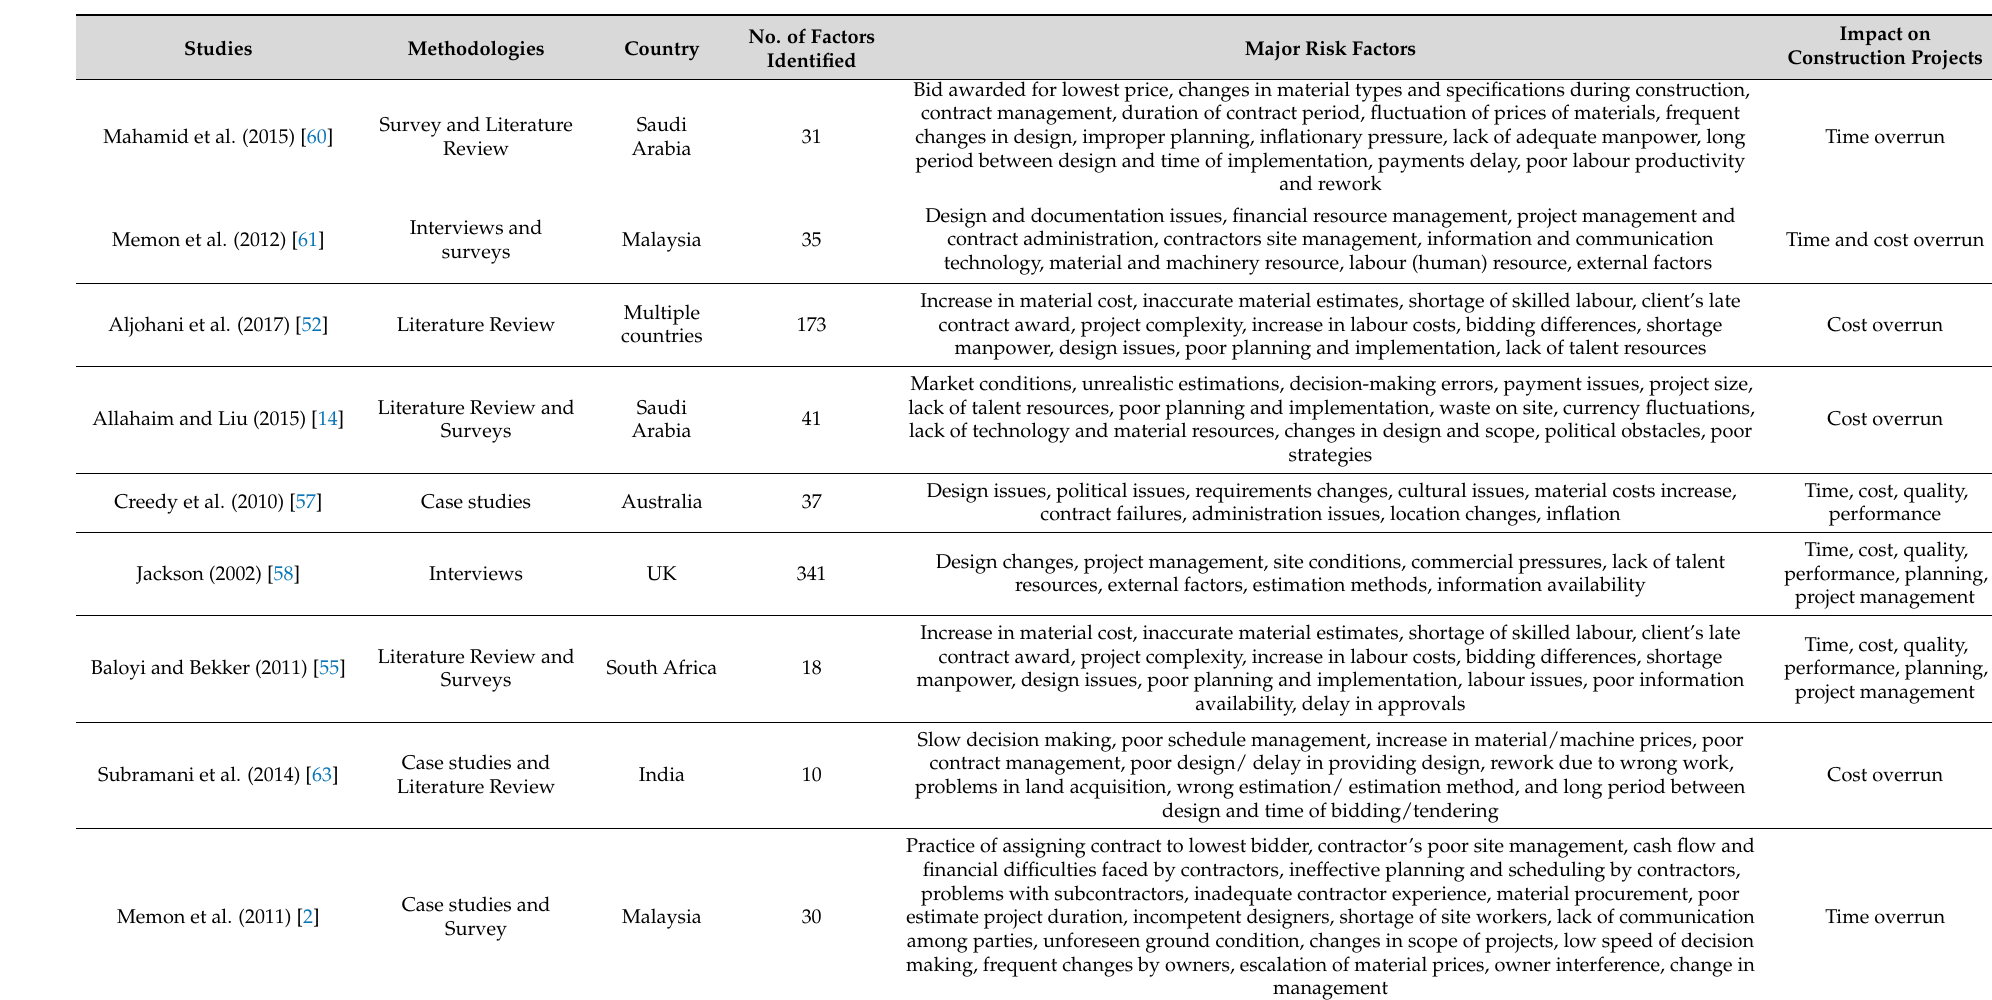
Table A1. List of major risk factors identified from the literature